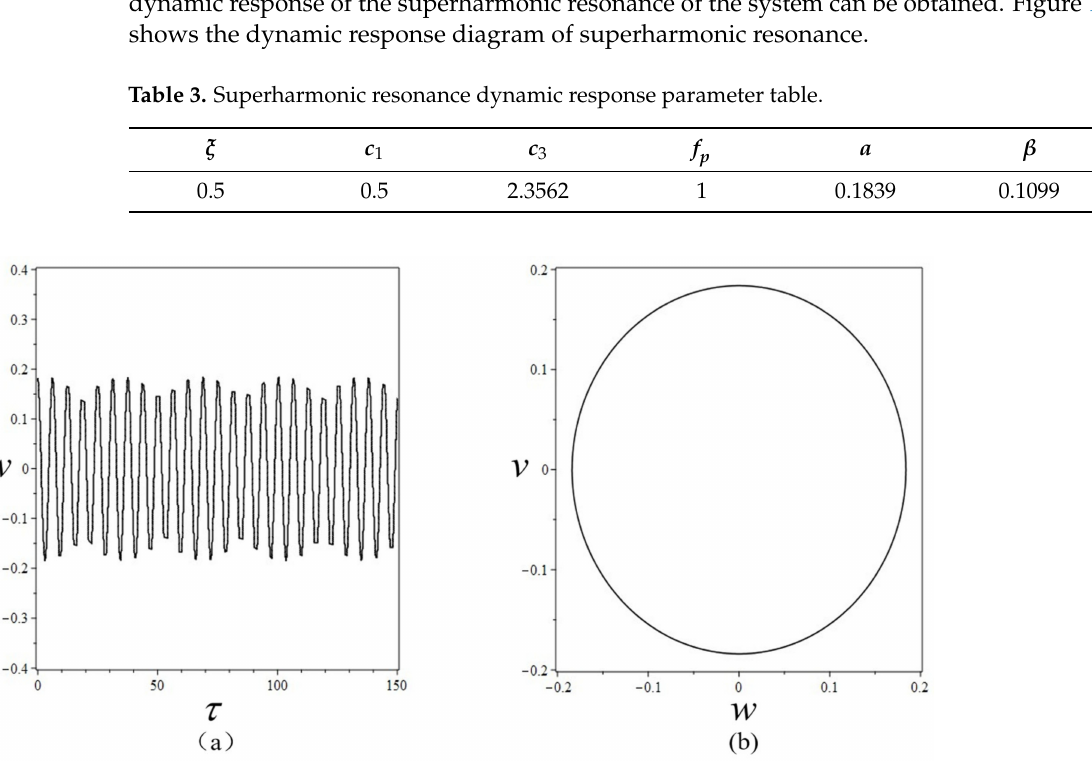
Figure 11. Dynamic response diagram of superharmonic resonance: ( a ) diagram of transverse displacement versus time, ( b ) phase